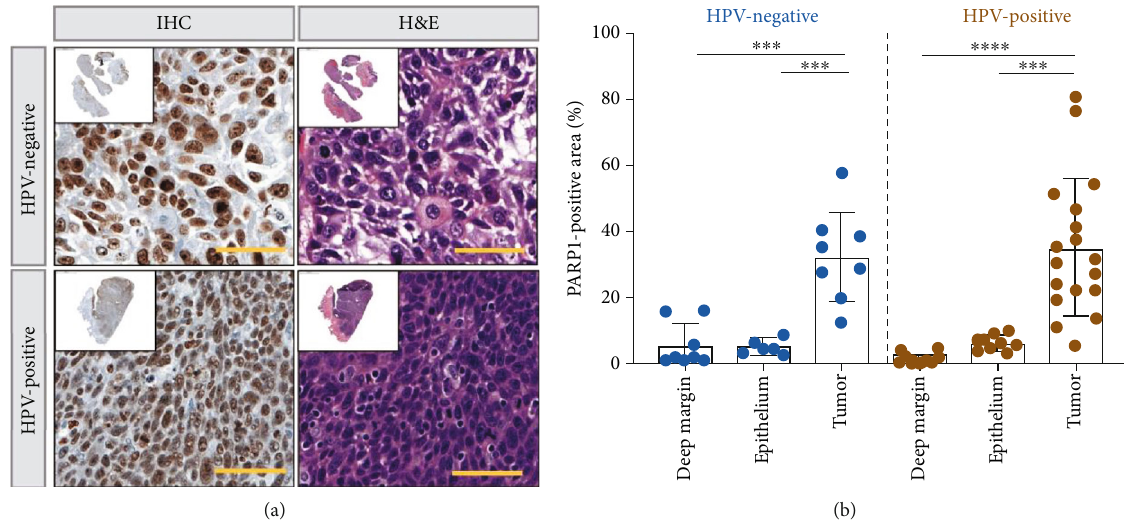
Figure 4: PARP1 expression in patient-derived oropharyngeal biospecimens. (a) PARP1 immunohistochemical staining of HPV-negative and HPV-positive oropharyngeal patient slides and H&E staining of corresponding sections. Scale bar 50 μ m. (b) PARP1 quanti fi cation of deep margin, epithelium, and tumor for all patient samples ( ∗∗∗ P < 0 : 001 , ∗∗∗∗ P < 0 : 0001 , Student t -test).